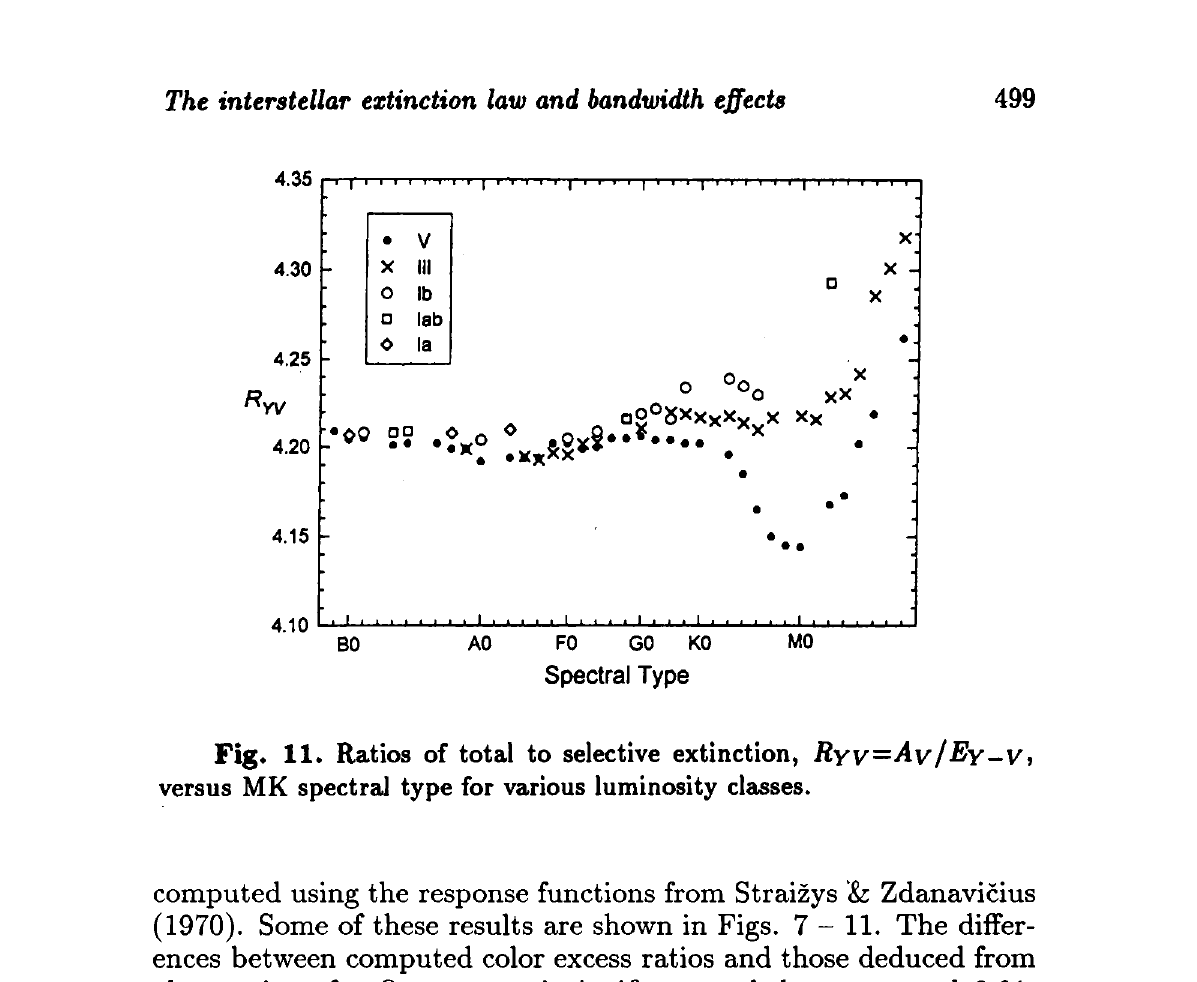
Fig. 11. Ratios of total to selective extinction, ϋγν=Αν/Εγ-ν, versus MK spectral type for various luminosity